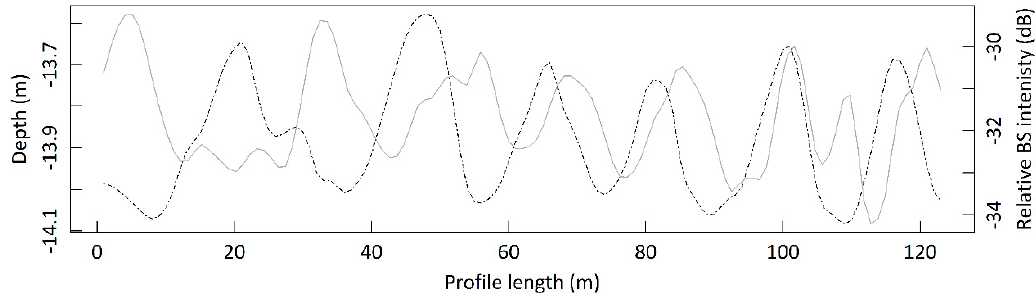
Figure 8. 2D profiles of bathymetry and backscatter extracted from 1-m horizontal resolution raster data within the ROI (Experiment II, Westdiep swale). Dotted line is depth, whereas the solid grey line is backscatter. Note the quasi-continuous reverse trend in the two profiles. A ~3 dB difference between troughs (lower BS ~ − 33 dB) and crests (higher BS ~ − 30 dB) suggesting the presence of different granulometries characterizing the ripples.